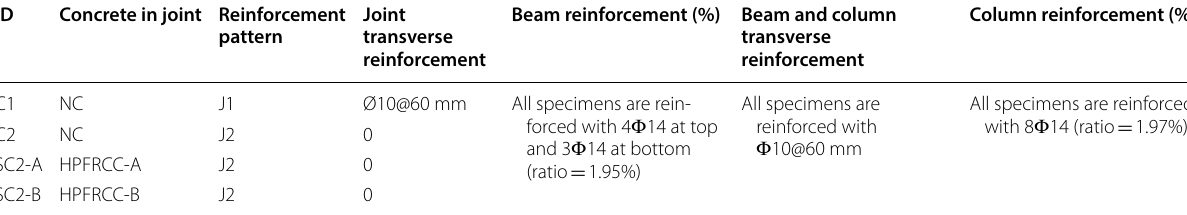
Table 5 Details of exterior beam-column connection.